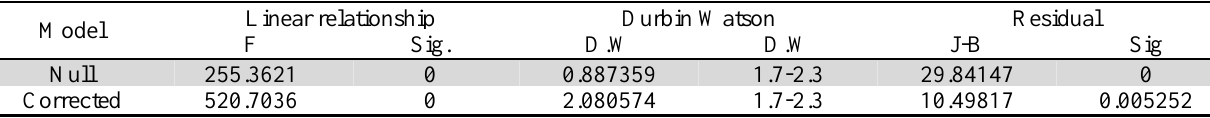
The summary of F-value and Durbin-Watson